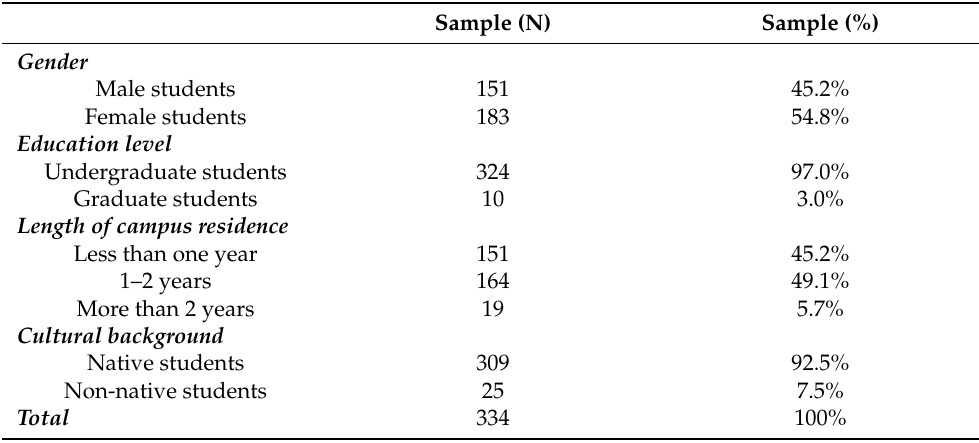
Table 1. Descriptive analysis of the sample